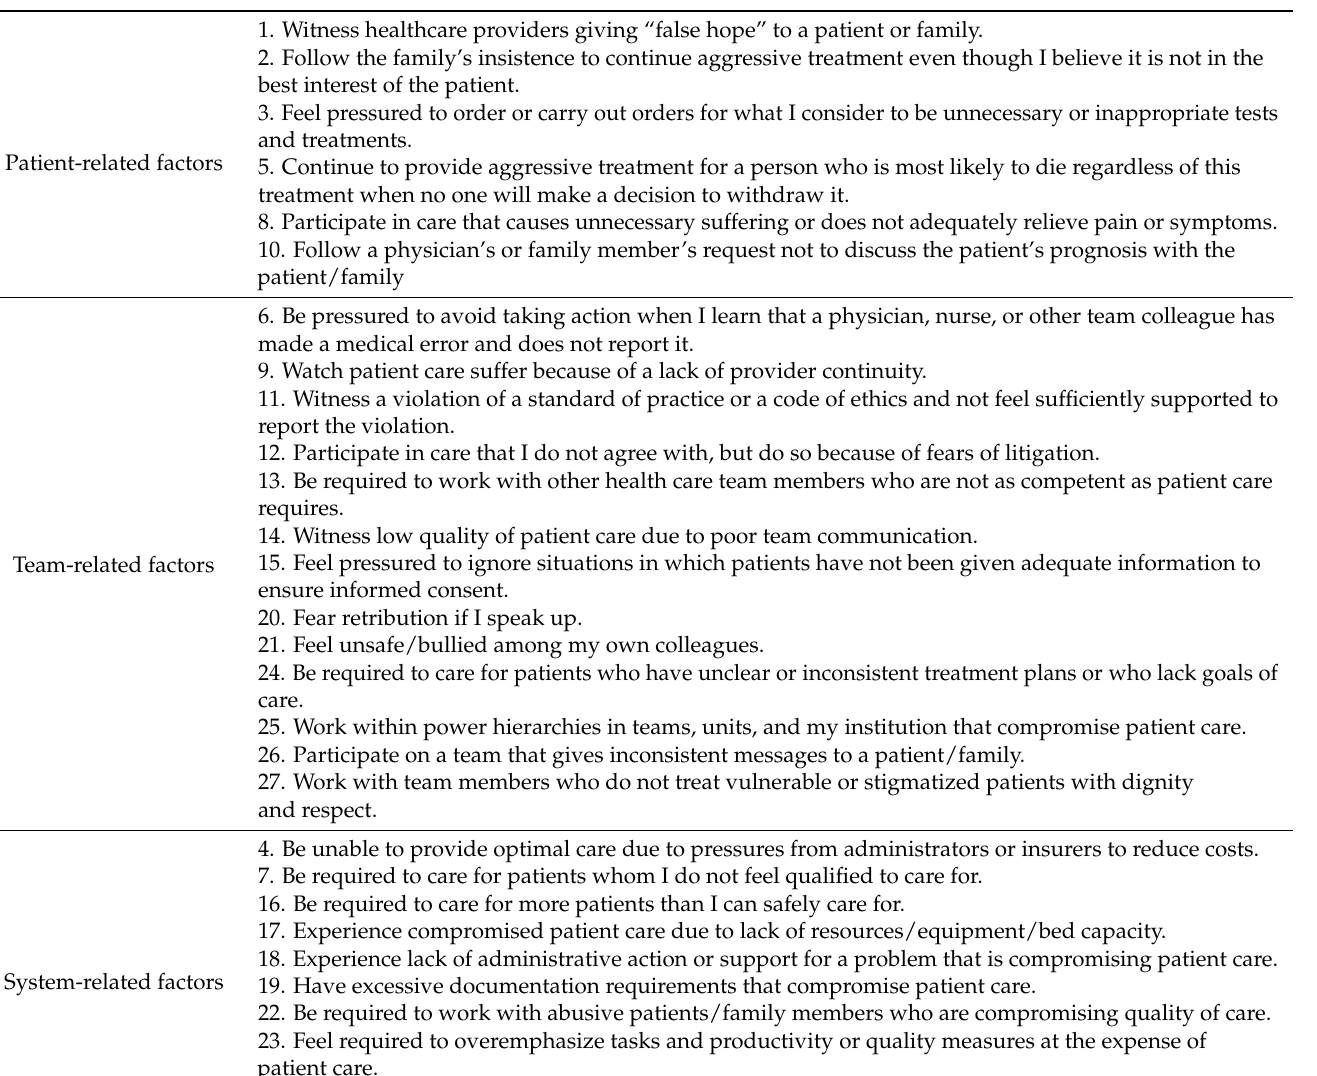
Table 1. MMD-HP score items grouped in three root causes for moral distress: patient-, team-, and system- related factors, as described by Epstein et al.